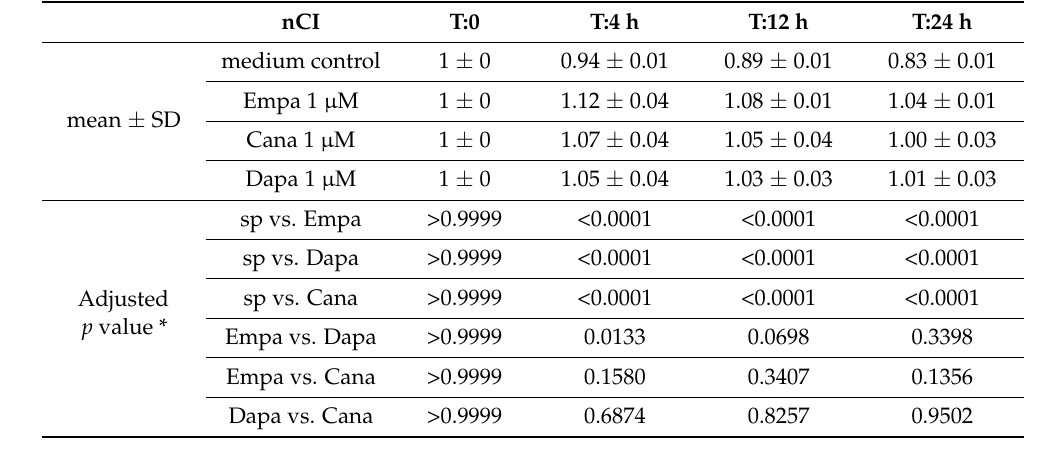
Table 1. Summary of the normalized cell index (nCl) of HUVECs incubated with SGLT2 inhibitors em- pagliflozin (1 µ M), canagliflozin (1 µ M), and dapagliflozin (1 µ M) in three time points T0, 4 h, 12 h, and 24 h. * Adjusted p value of Tukey multiple comparisons tests in 2-way ANOVA.